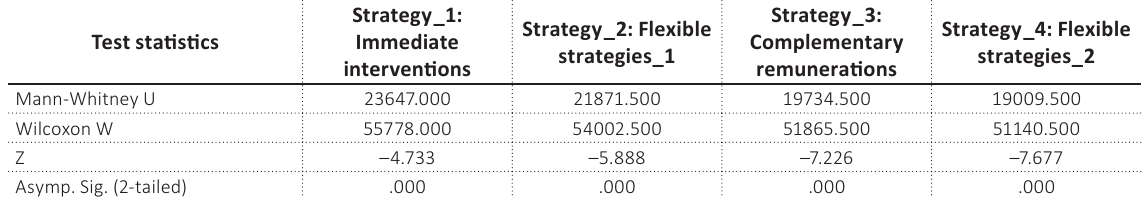
Table 11. Test statistics a for the presence of unions and non-wage cost-cutting strategies